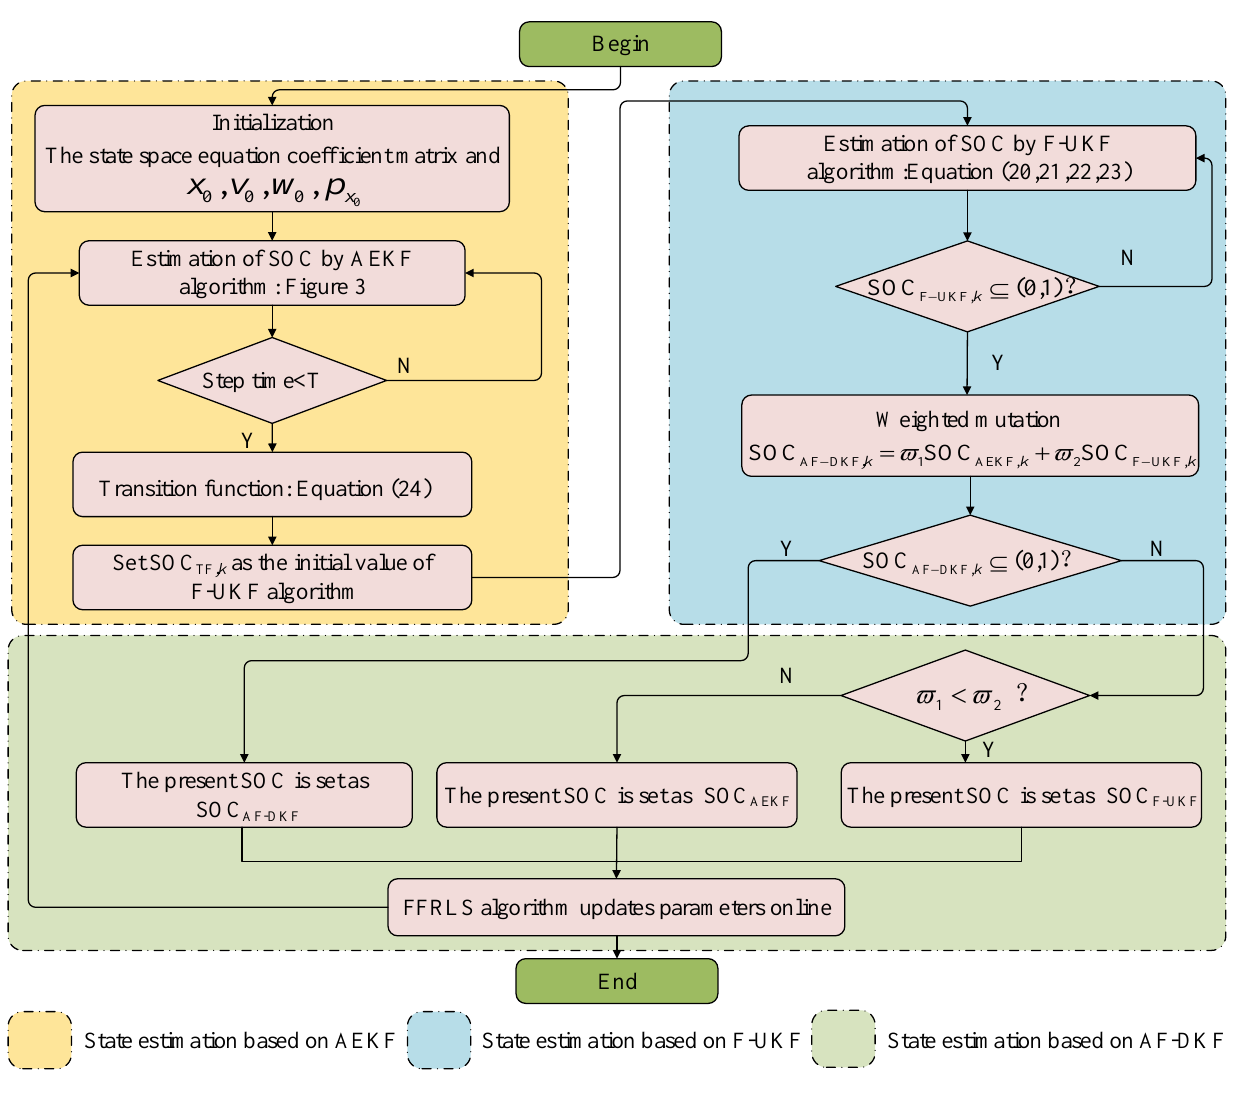
Figure 5. AF-DKF algorithm flow chart.